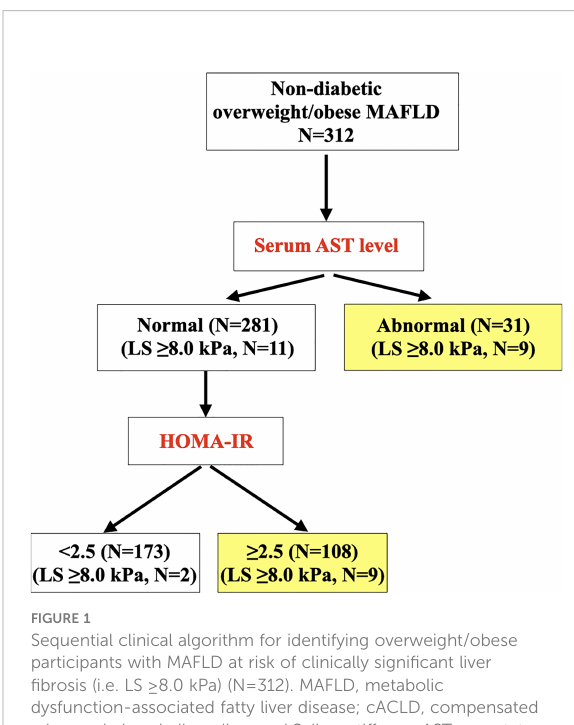
FIGURE 1 Sequential clinical algorithm for identifying overweight/obese participants with MAFLD at risk of clinically signi fi cant liver fi brosis (i.e. LS ≥ 8.0 kPa) (N=312). MAFLD, metabolic dysfunction-associated fatty liver disease; cACLD, compensated advanced chronic liver disease; LS, liver stiffness; AST, aspartate aminotransferase; HOMA-IR, homeostasis model assessment of insulin